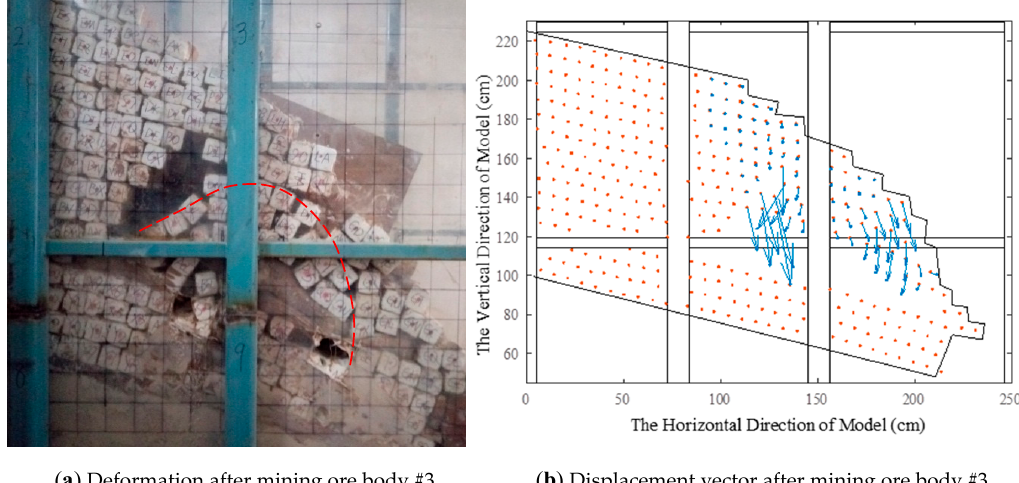
Figure 11. Slope deformation and displacement vector after mining ore body #3.